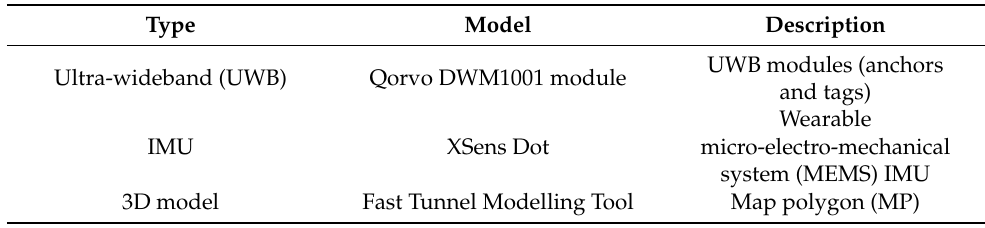
Table 1. Selected Navigation